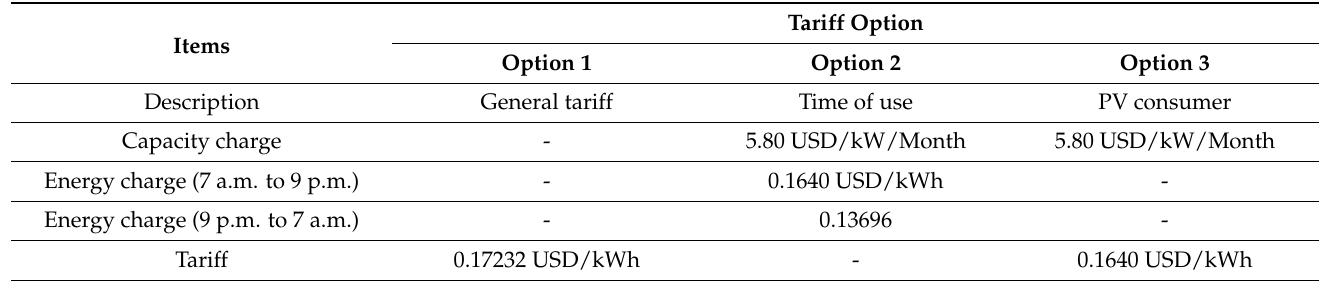
Table 1. Regulation for utilities and electricity tariff for consumers with meter at a low voltage of the licensee’s transformer.